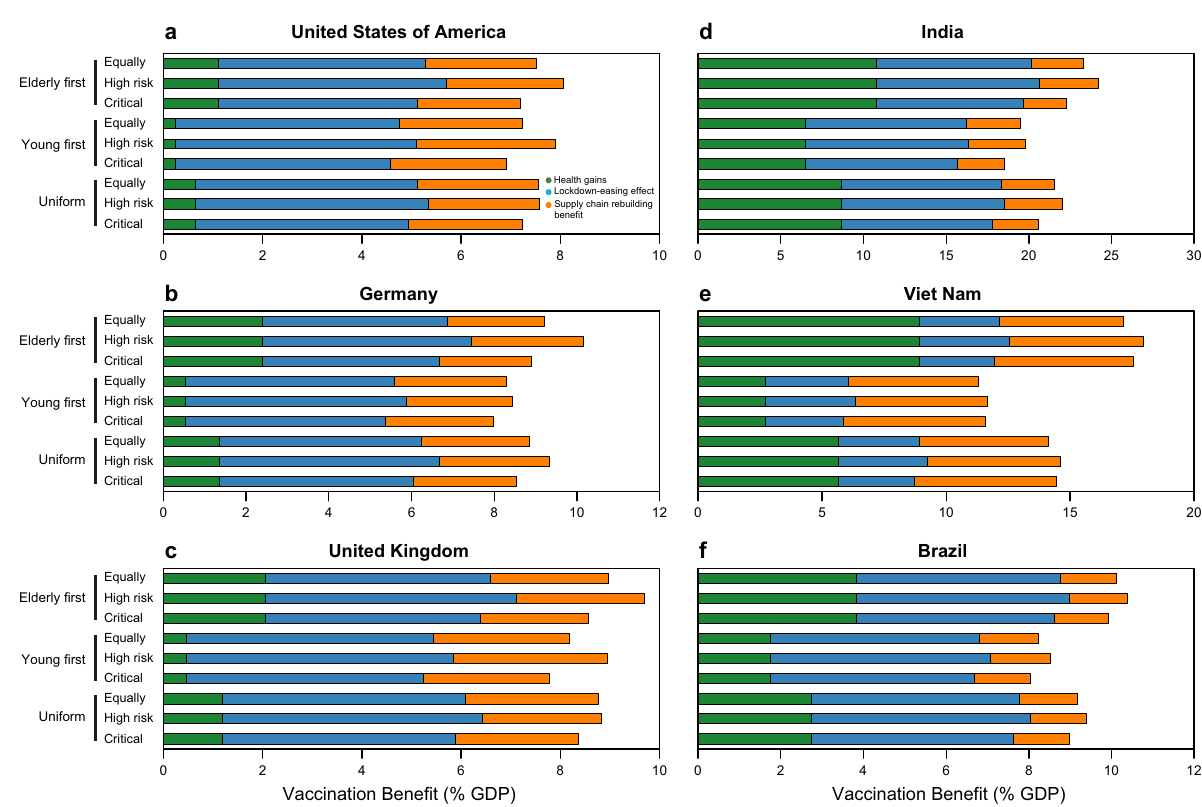
Fig. 4 | Vaccination-related bene fi ts under different domestic vaccine- distribution strategies for selected countries. Three types of bene fi ts (health gains, lockdown-easing effect and supply-chain rebuilding bene fi t) under nine scenarios with different combinations of vaccination priority groups by age and priority of workforce in different industrial sectors (see Fig. 1 and Supplementary Fig. 1). The panels in the left column show the results for three well-developed majorvaccine-producingcountries(i.e., a theUnitedStatesofAmerica, b Germany, and c the United Kingdom). The panels in the right column (Fig. 4d – f) show the